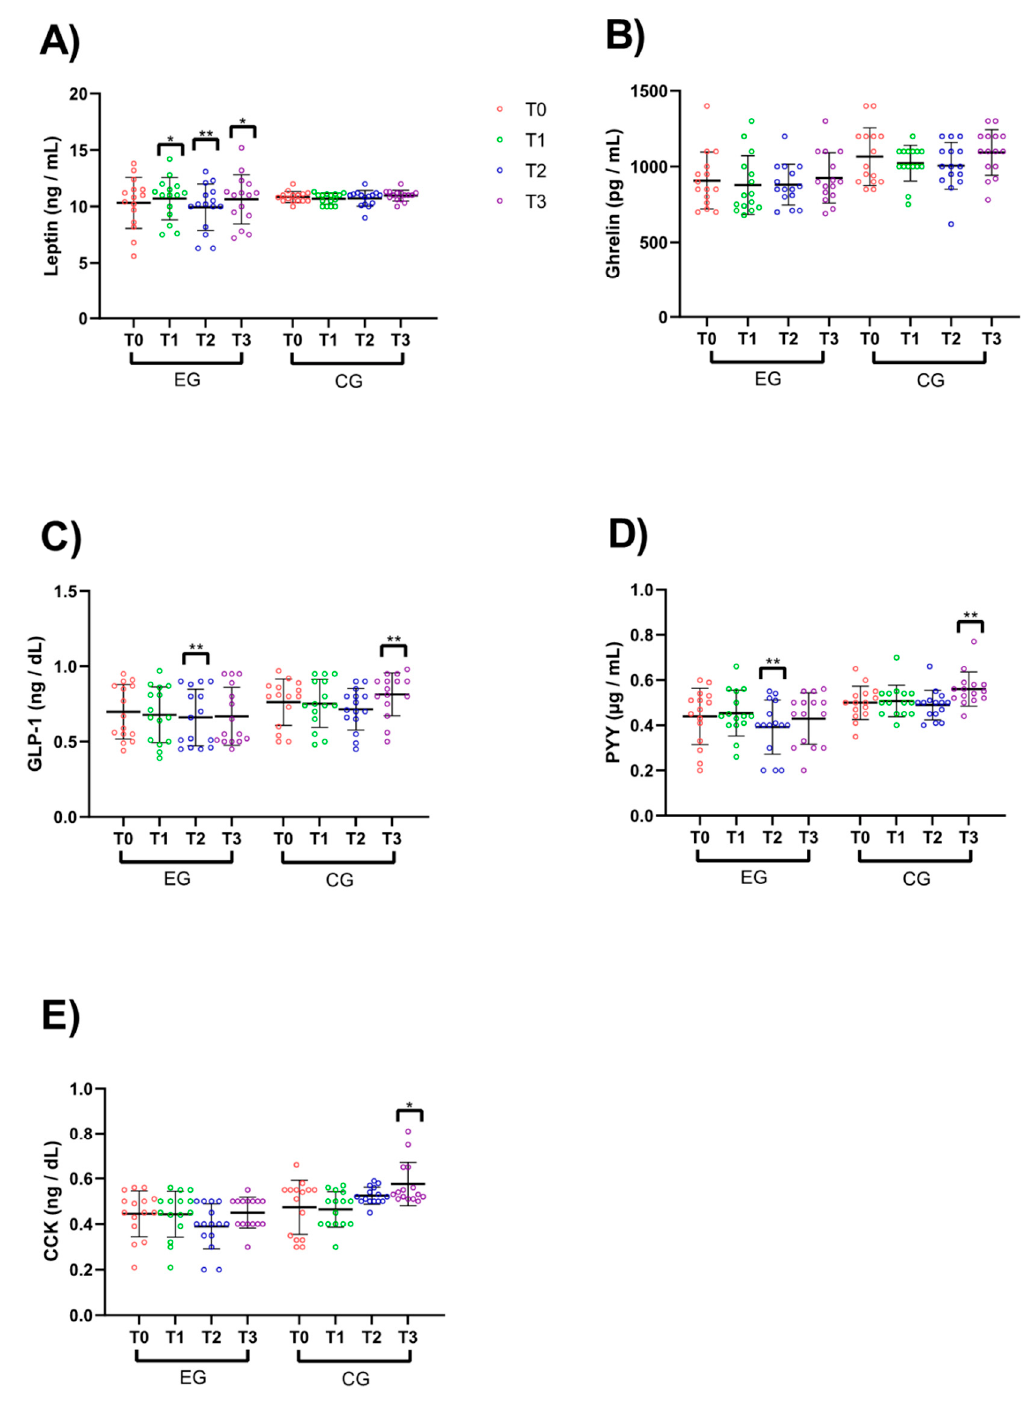
Figure 3. Hormone concentration values. ( A ) Leptin, ( B ) ghrelin, ( C ) glucagon-like peptide-1 (GLP-1), ( D ) peptide YY (PYY), and ( E ) cholecystokinin (CCK). * Significant difference from T0. * p < 0.05; ** p < 0.01.